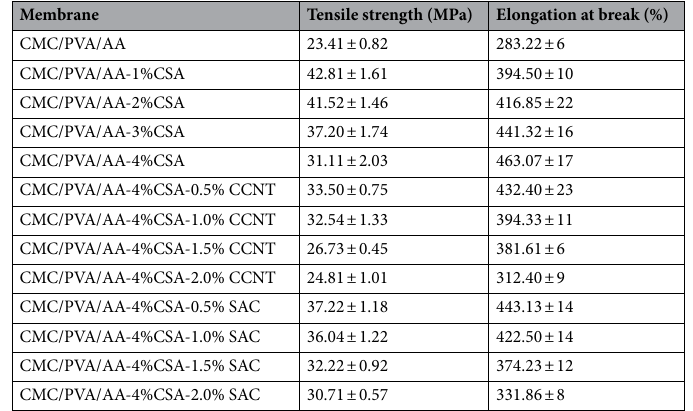
Table 3. Tensile strength and elongation at break of CMC/PVA/AA and modified CMC/PVA/AA hybrid polyelectrolytic membranes with different amounts of CCNT and SAC.